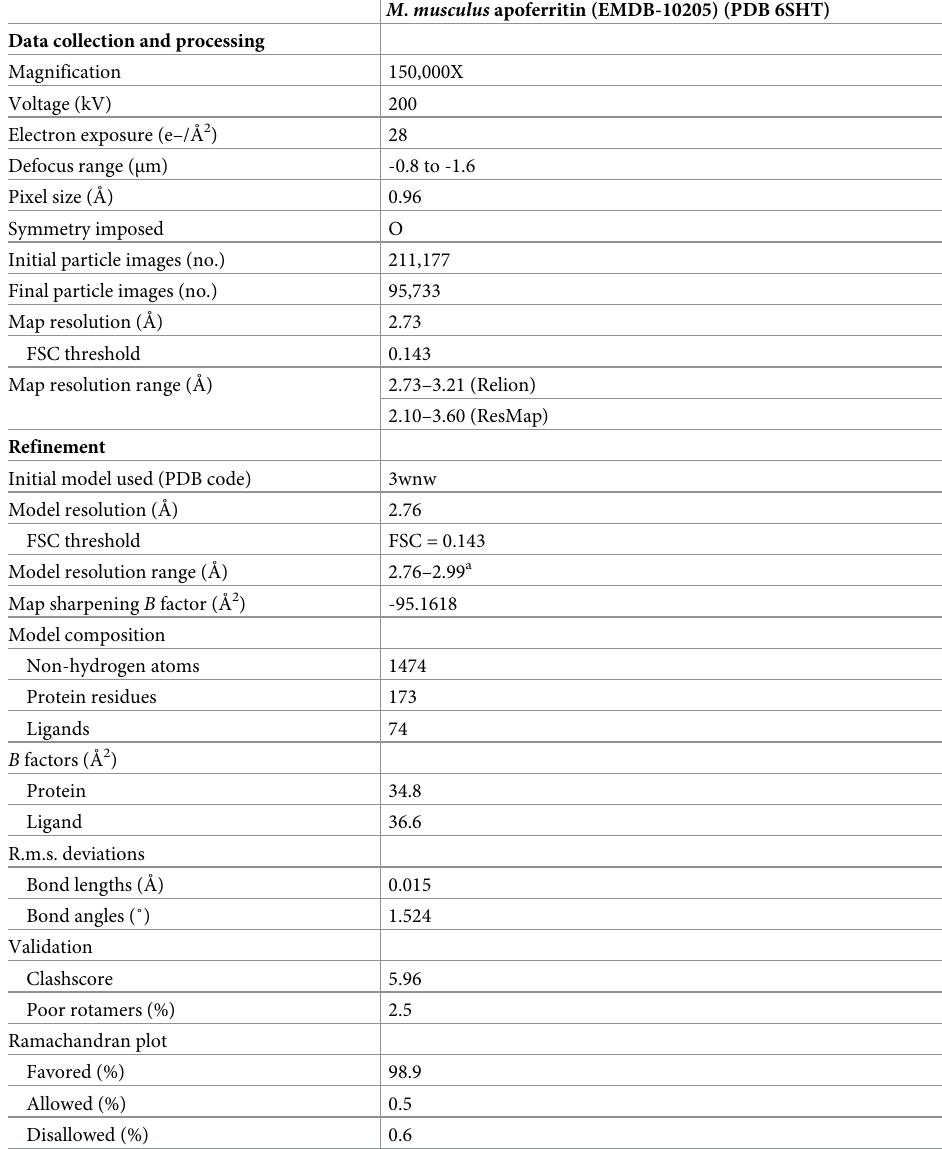
Table 1. Cryo-EM data collection, refinement and validation